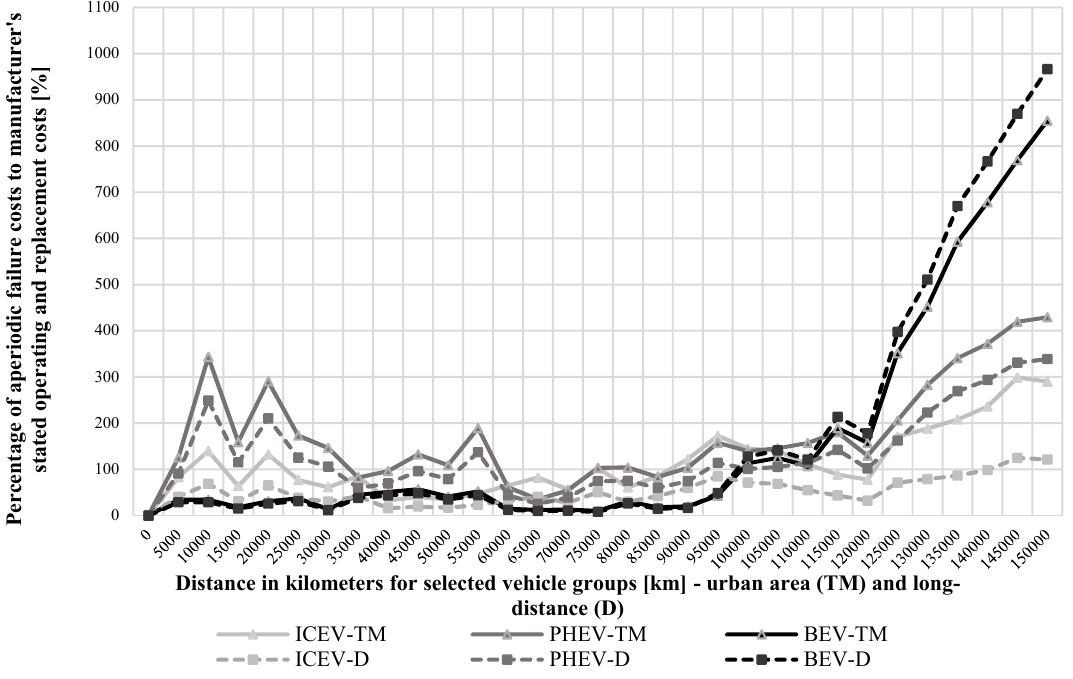
Figure 14. Percentage of aperiodic failures cost in the entire balance of vehicle operating costs resulting from periodic inspections and replacement of components recommended by the manufacturer—4x4 vehicle.